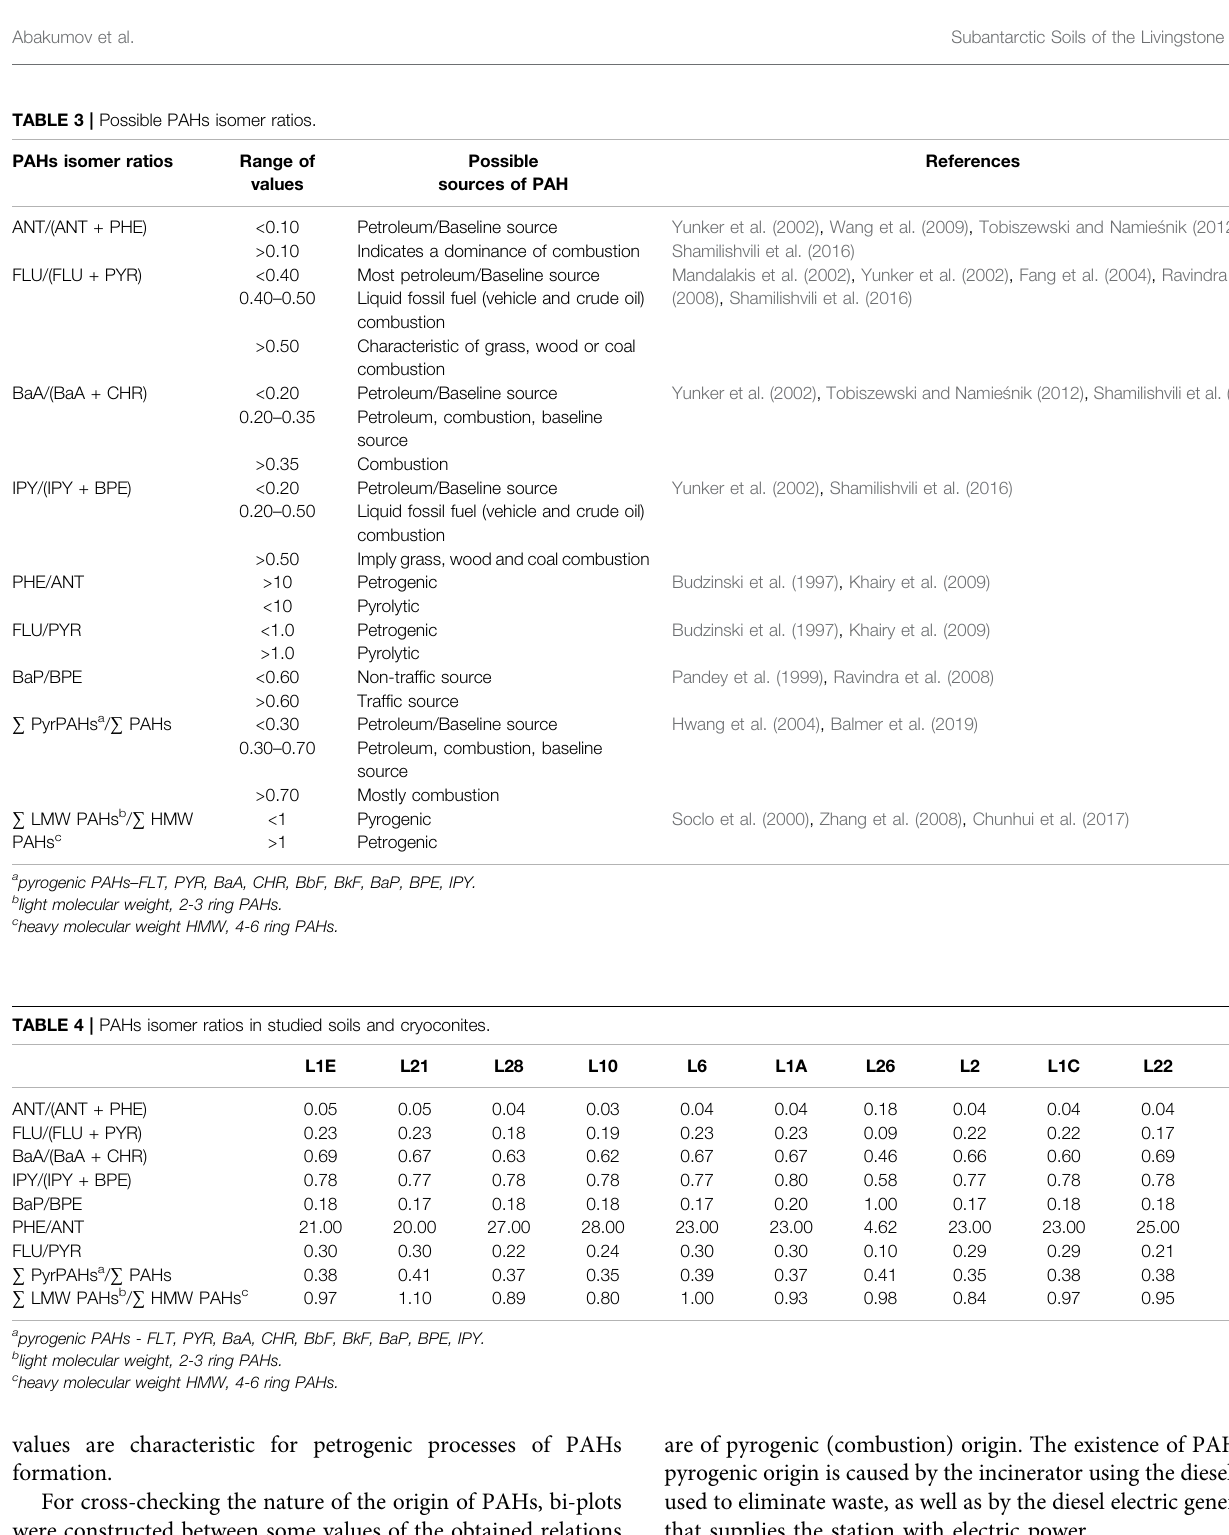
Possible sources of PAH